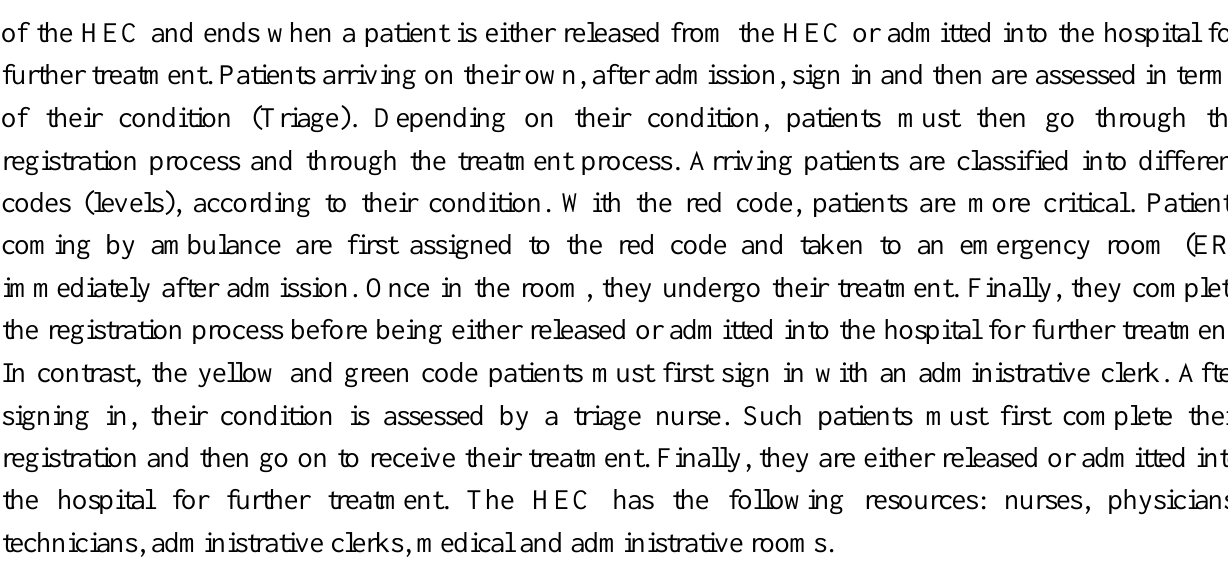
Figure 14. Hospital emergency center: BPMN process